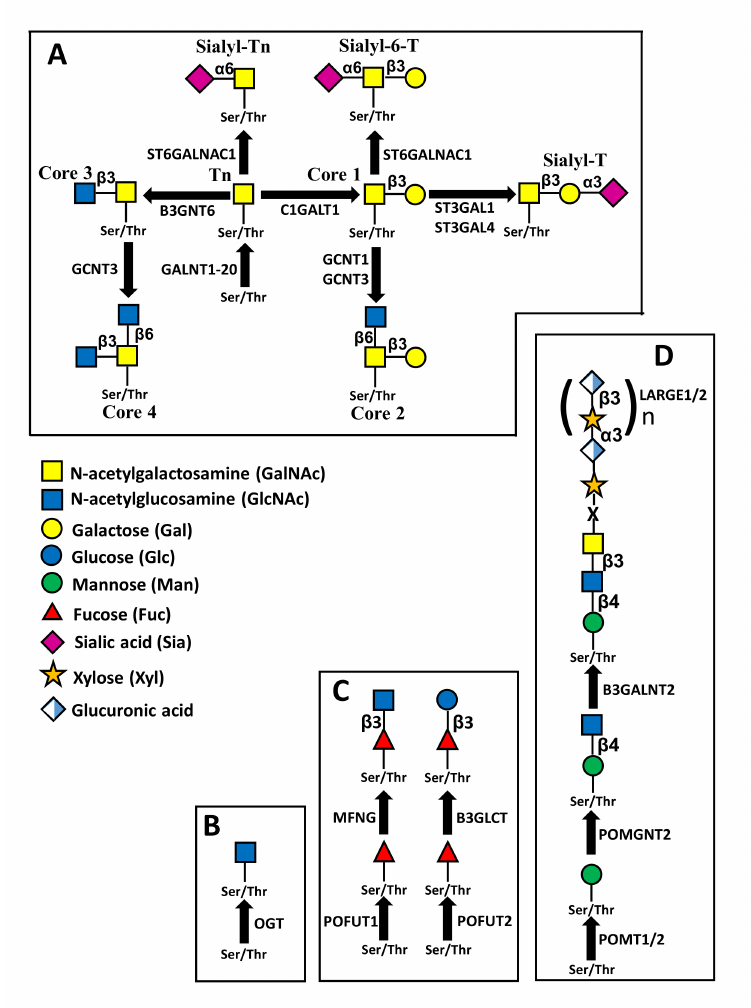
Figure 2. Structures of different types of O -linked chains. ( A ) structure and biosynthesis of mucin- type O -linked chains. Four “core” structures are shown, which can be elongated by other sugars. ( B ) Addition of O -linked GlcNAc, mediated by O -GlcNAc transferase. Removal of the sugar is catalyzed by O-GlcNAc ase (not shown). ( C ) O -fucosylation. The O -linked fucose mounted on EGF repeats by POFUT1 can be elongated by β 3GlcNAc through manic fringe (MFNG) and also by β 4Gal and α 6Sia (not shown). The O -linked fucose mounted on TSRs repeats by POFUT2 can be elongated by β 3Glc ( D ) O -mannosylation. The structure shown is referred to as M3 and can be elongated by the repeated units of xylose and glucuronic